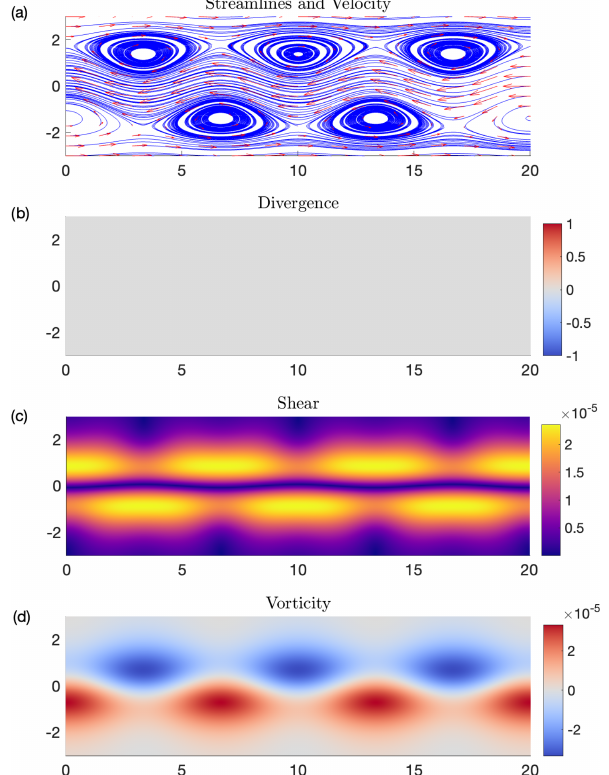
Figure A1. (a) Streamlines and velocity vectors for the geophysi- cal Bickley jet. (b) The flow is designed to be divergence-free, as can be verified by a uniform divergence value of zero. (c) Instan- taneous values of shear indicate strong shear zones adjacent to the top and bottom eddies and a narrow shear-free core. (d) Vorticity fields correctly identify the centers of the eddies above and below the jet. Note that the contours of shear do not agree with the shape of eddies in (a) and (d) .